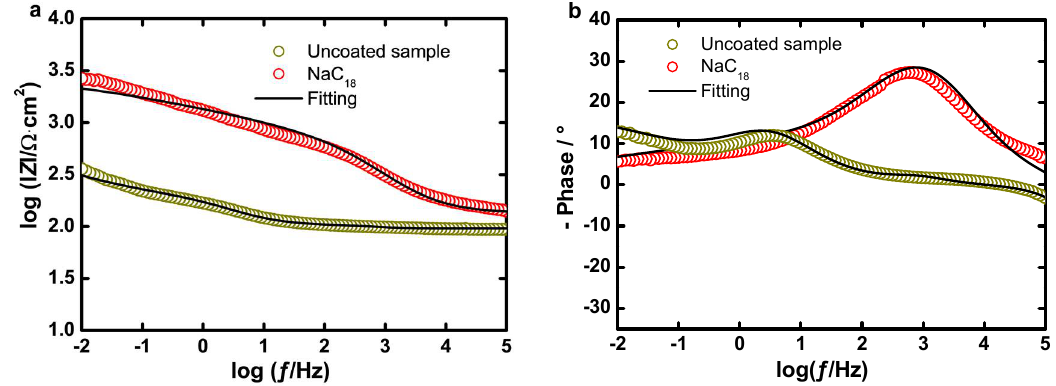
Figure 6. Bode plot in a 0.1 M TBAB solution containing 5 µg·L −1 acetic acid of lead coupons coated in a 50 mM NaC 18 solution for 24 h: ( a ) modulus plot; ( b ) phase angle.